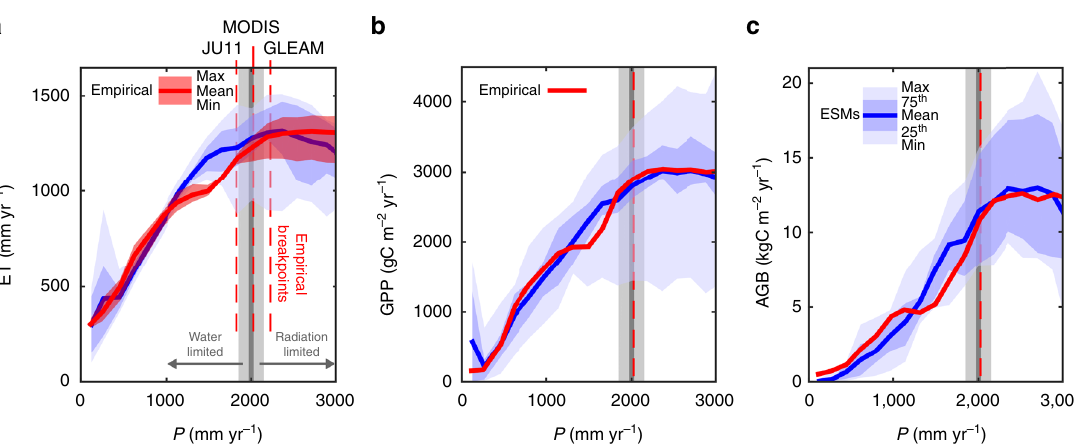
Fig. 3 Functional precipitation relationships. a Evapotranspiration (ET) response to precipitation ( P ) from nine ESMs ( blue shaded areas and solid line ) and calculated from three empirical data sets, MODIS MOD16 16 , upscaled eddy- fl ux tower estimates 15 (JU11) and GLEAM v3.0a 17, 18 . Grey vertical line and shading represent an independent, empirical, estimate of the breakpoint between water-limited and radiation-limited control of GPP 21 (gross primary productivity). The shading represents the range of estimated breakpoints across tropical forest locations globally. Dashed red lines show breakpoints in the empirical data sets, found in a trend break analysis (Supplementary Fig. 2). b GPP response to P of ESMs and empirical GPP from upscaled eddy- fl ux estimates 15 . c AGB response to P of ESMs and satellite-derived vegetation optical depth (VOD)-based estimates of AGB 3 . All empirical data products were combined with P from GPCC v7 57 corrected following